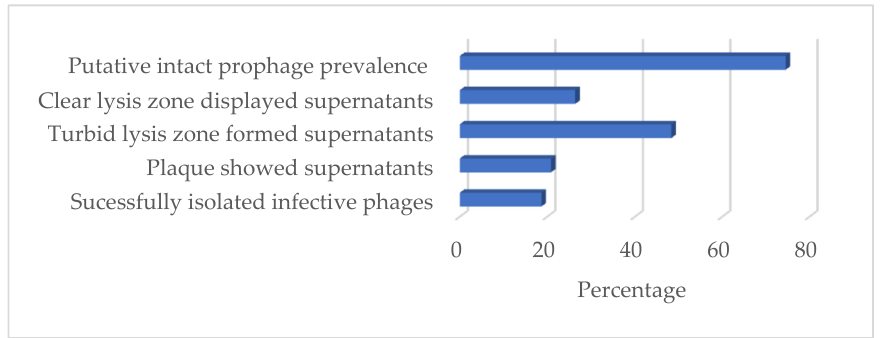
Figure 8. Prevalence of in silico-predicted prophages and UV-light inducible of prophages in B. subtilis .